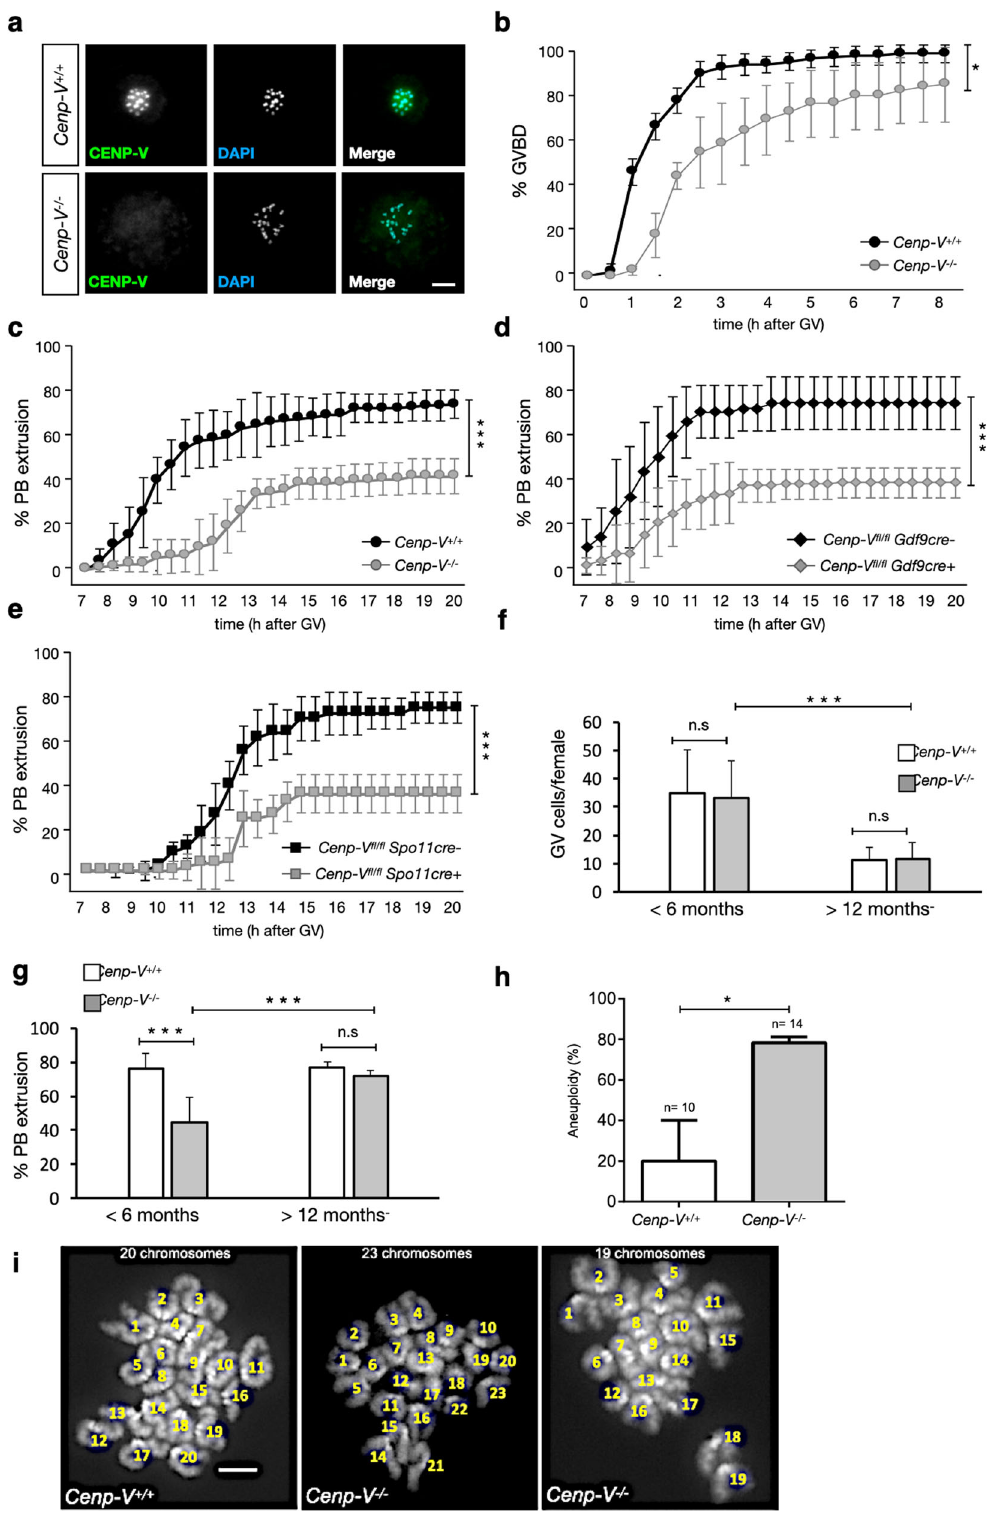
chromosomes proceed to PBE and MII (Fig. 4b). Notably, unlike young Cenp-V − / − oocytes, aged Cenp-V − / − oocytes proceeded to PBE like controls (Fig. 2g). In the aged Cenp-V − / − oocytes a strongly increased frequency of cells carrying misaligned chro- mosomes was observed (Fig. 4b). The absence of MI arrest in aged oocytes despite this presence of mis-aligned chromosomes con fi rms that the SAC is not as active anymore in oocytes